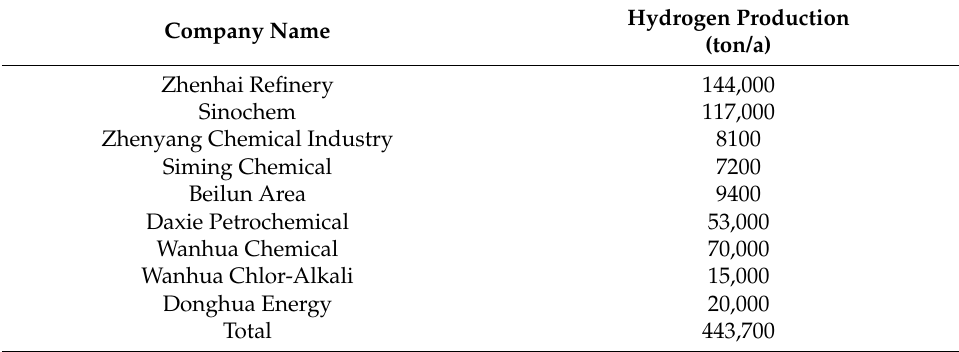
Table 3. Industrial by-product hydrogen in Ningbo area.